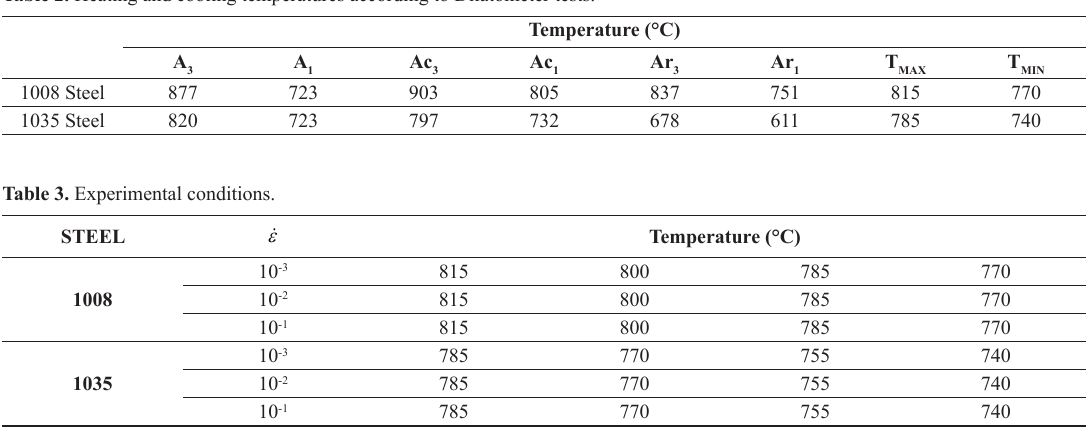
Table 2. Heating and cooling temperatures according to Dilatometer tests.